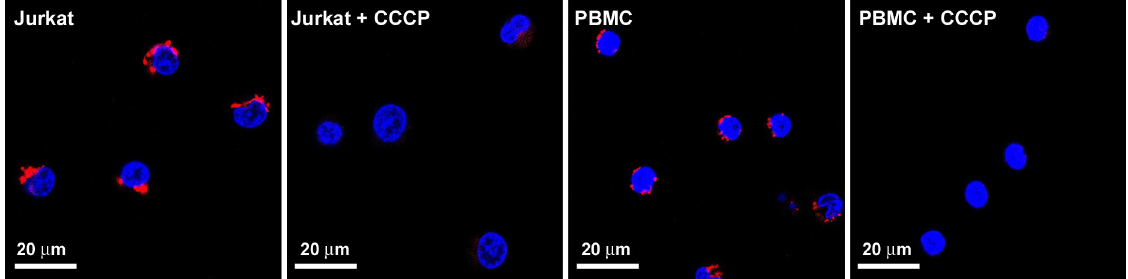
Fig 4. CCCP induces mitochondrial depolarisation in Jurkat and PBMC samples. Fluorescent micrographs of Jurkat and PBMC samples loaded with the red fluorescent, mitochondrial membrane potential-dependent dye TMRM before and after addition of 20 μ M CCCP (+ CCCP). Nuclei were counterstained fluorescent blue with Hoechst